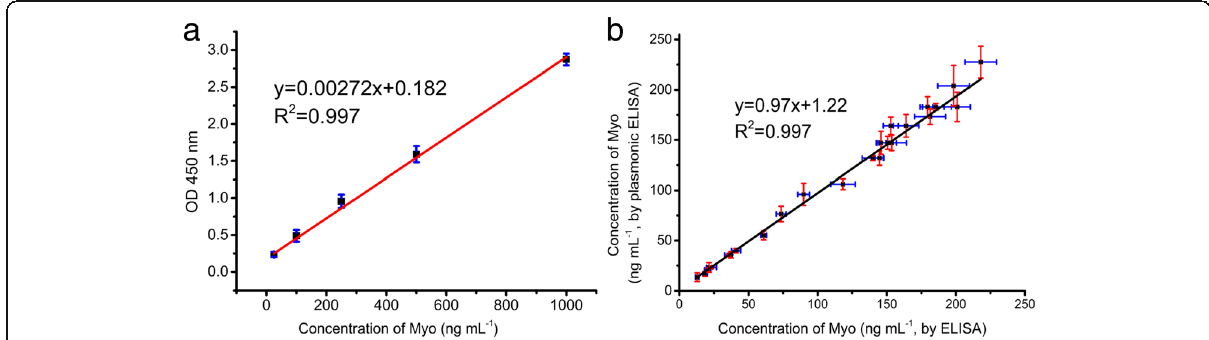
Fig. 5 Comparison of the plasmonic immunoassay and conventional ELISA for Myo detection. a Calibration line of ELISA for Myo detection. b Comparison of the plasmonic immunoassay and conventional ELISA in testing serum samples. The transverse axis represents results from ELISA and the vertical axis represents results from the plasmonic immunoassay. Each value presents the mean from three